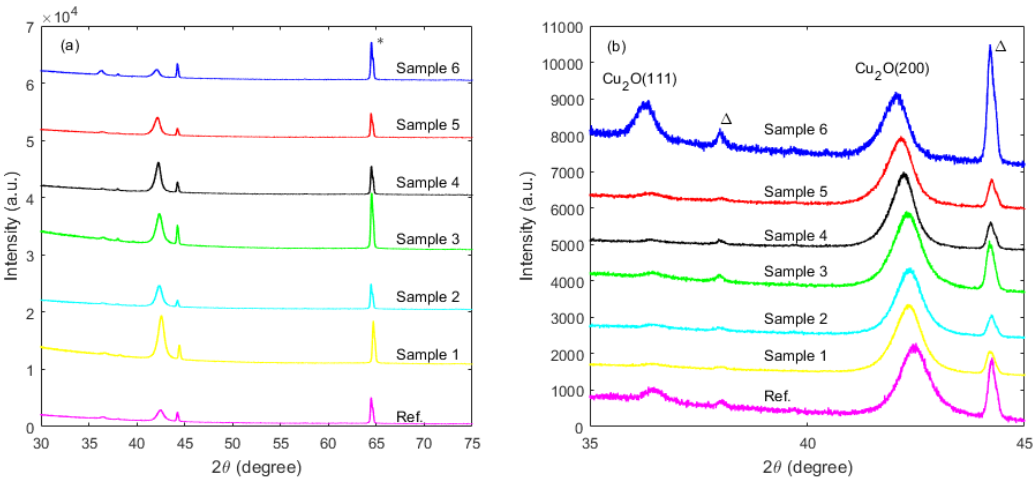
Figure 2. 2 θ – θ scans for N:Cu 2 O thin films on quartz in the range ( a ) 30 ◦ –75 ◦ and ( b ) 35 ◦ –45 ◦ . The asterisk * indicates the peak of the quartz substrate, whereas ∆ indicates the peaks of the sample holder.